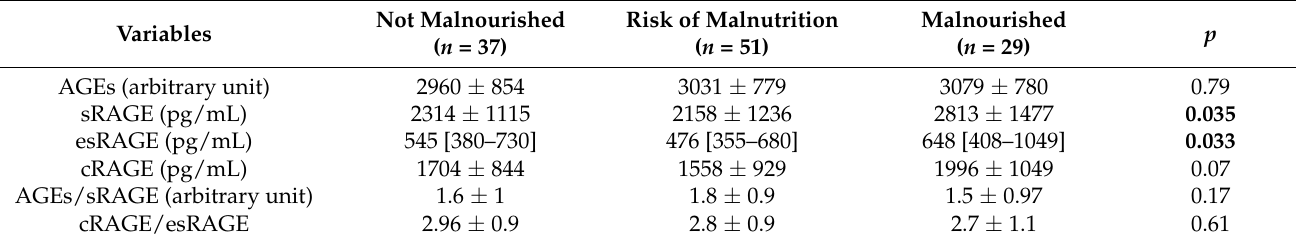
Table 4. Concentration of AGEs and sRAGE isoforms in not malnourished, at risk of malnutrition and malnourished CKD patients.